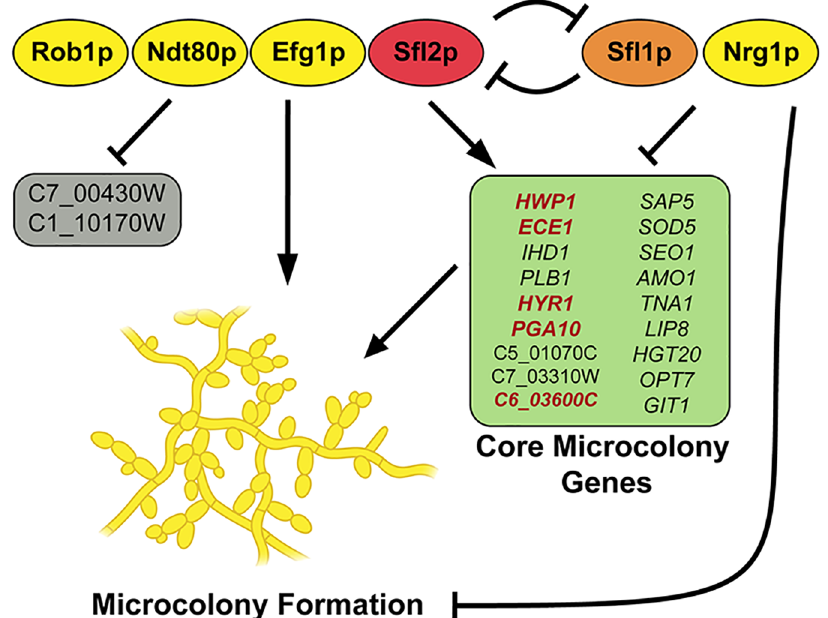
Fig 8. Model of the regulatory elements of Candidaalbicans microcolony formation. Six core microcolony transcriptional regulators (four positive [left], two negative [right]) are involved in microcolony formation, and regulation of core microcolony genes. SFL1 (orange) and SFL2 (red) have antagonistic roles, SFL2 is active at higher temperatures and inhibits SFL1 and NRG1 ,while SFL1 and NRG1 are active at lower temperatures. In microcolony forming conditions, the four positive microcolony transcriptional regulators (Rob1p, Ndt80p, Efg1p, and Sfl2p) work together to regulate the core microcolony genes (arrows indicate upregulation/promotion and blunt ends indicate downregulation/inhibition), and promote the formation and function (adhesion and invasion) of microcolonies. Core microcolony genes (in red) influence the size or density of microcolonies.